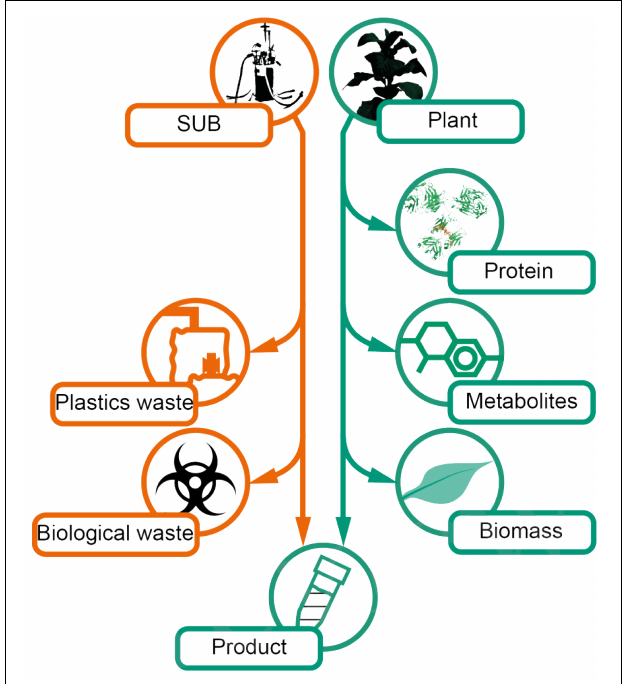
FIGURE 2 | Comparison of waste streams generated in a mammalian cell culture-based process relying on single-use equipment and a plant-based counterpart. SUB, single-use